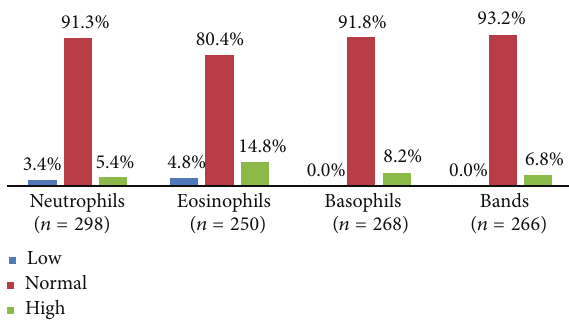
Figure 3: Granulocyte subpopulations counts.